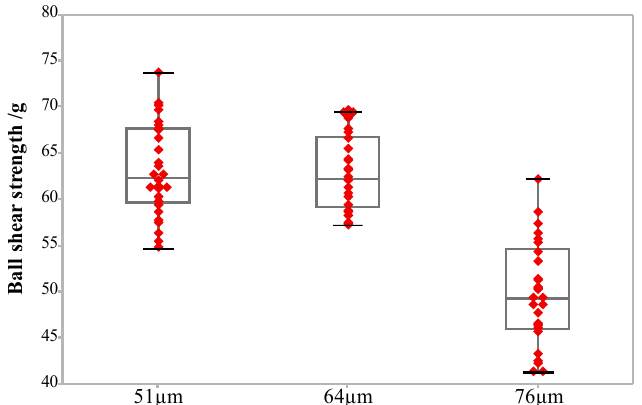
Figure 9. The shear strength of the ball bonded points when the ICAD is 51, 64 and 76 μ m.